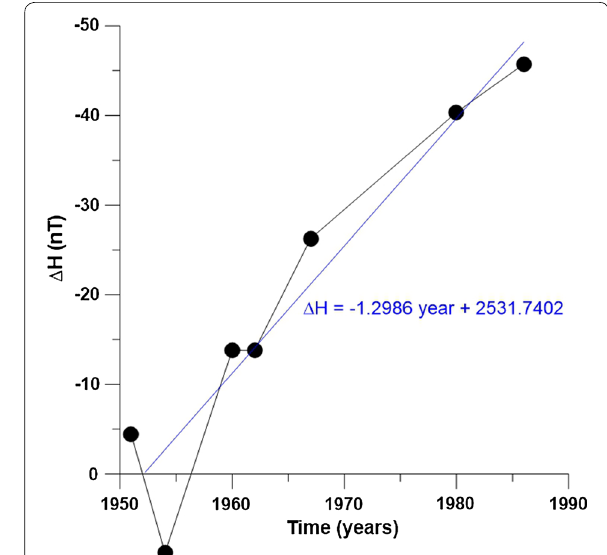
Fig. 7 Temporal evolution of the differences between H values at Ebro computed with the original coefficients and those corrected after the international comparisons. Black dots point out the moments when the calibrated QHM visited Ebro. The blue line is the best fit